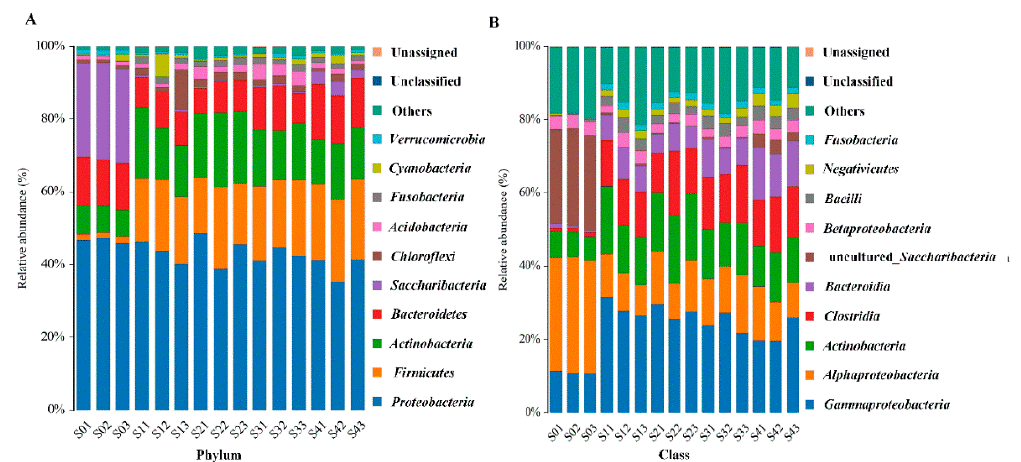
Figure 2. Relative abundance of bacterial at the phylum and class levels. ( A ) represent the phylum of bacterial; ( B ) represent the class of bacterial; S01–S03, S11–S13, S21–S23 S31–S33, and S41–S43 represent the relative abundance of bacteria in S0, S1, S2, S3, and S4, respectively.